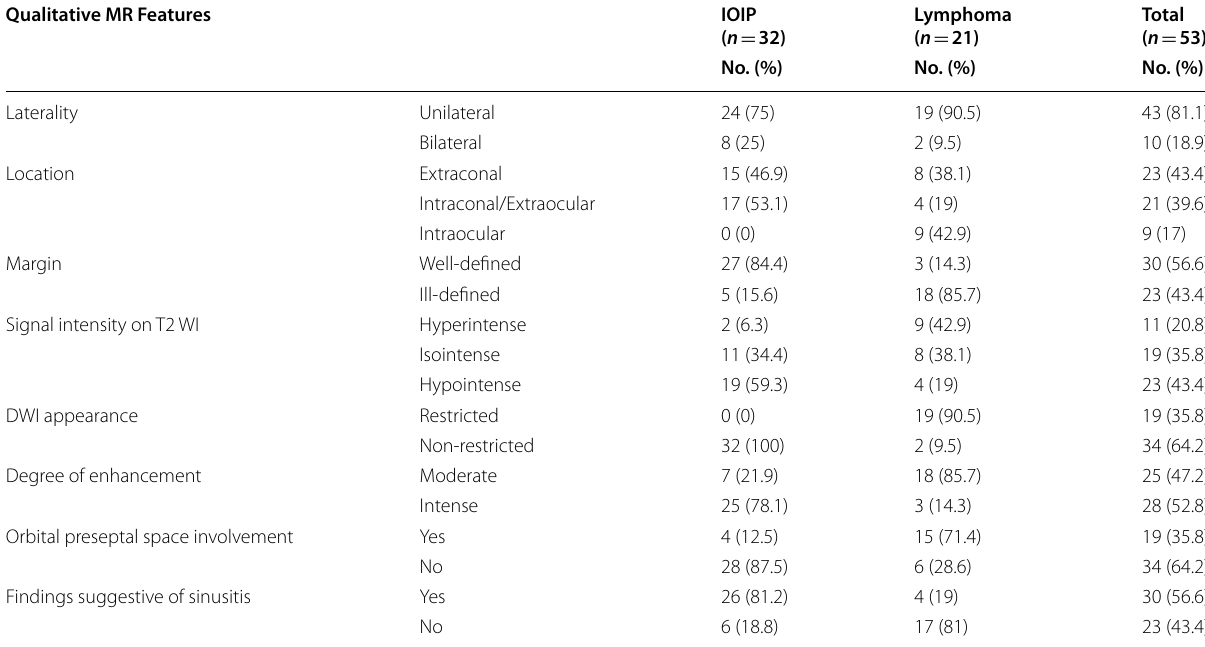
Table 2 Frequency distribution of qualitative MRI features within our cases Qualitative MR Features